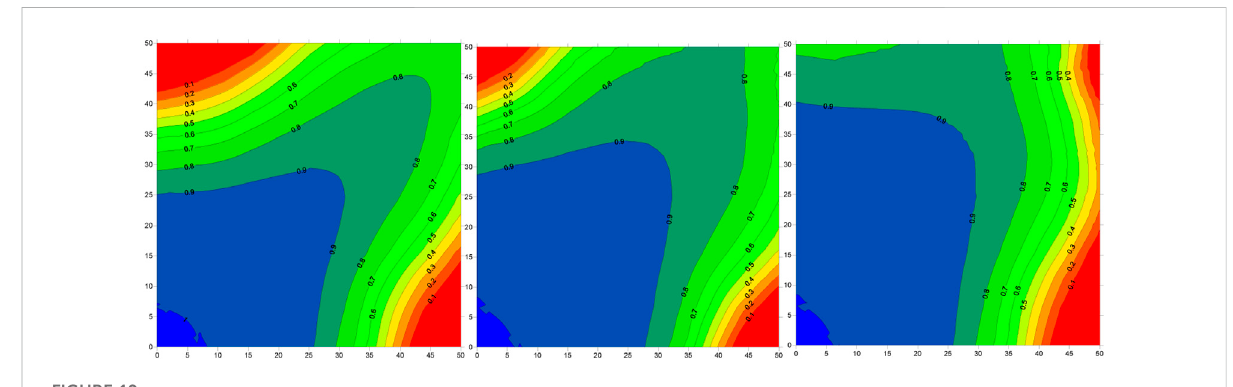
FIGURE 19 Water displacement in models 1, 2, and 3.